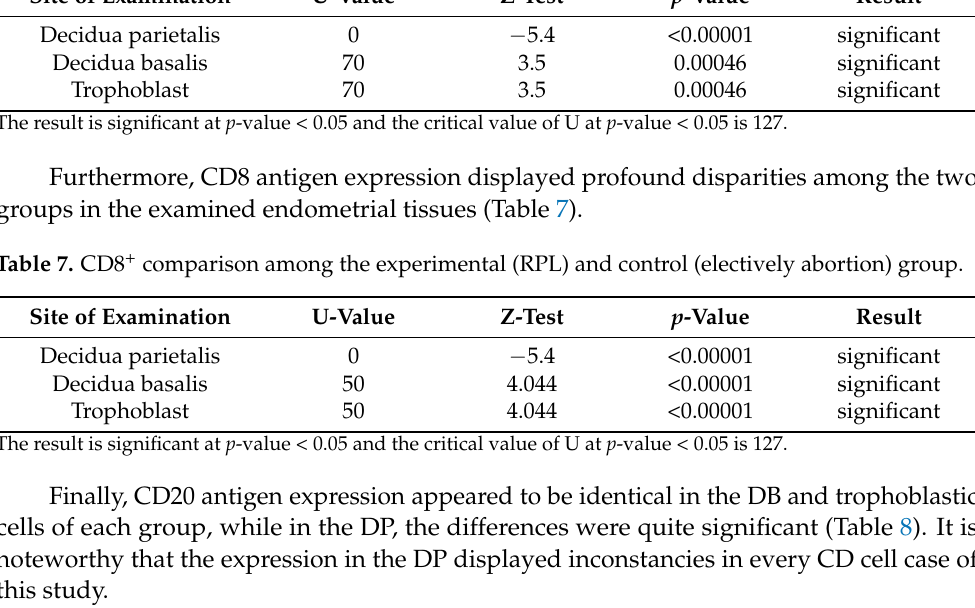
Table 6. CD4 + comparison among the experimental (RPL) and control (electively abortion) group. Site of Examination